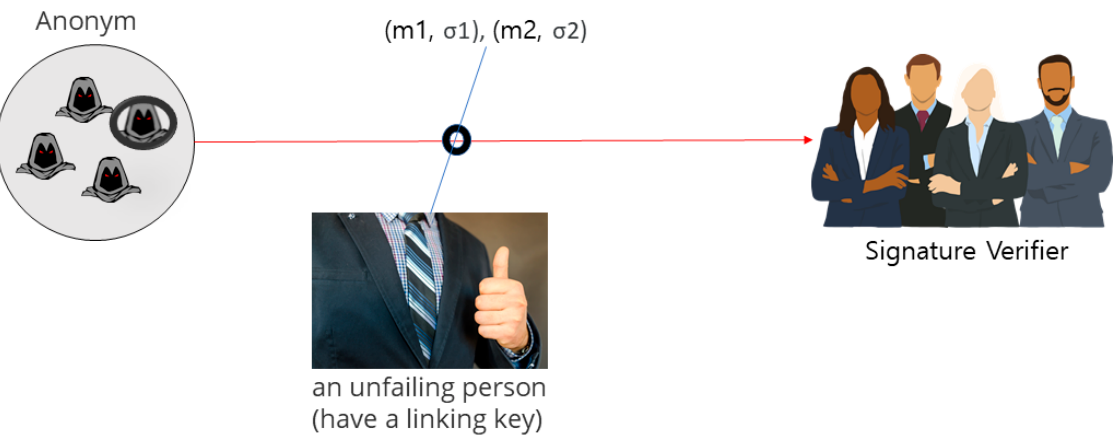
Figure 5. The group signature method based on connectivity.